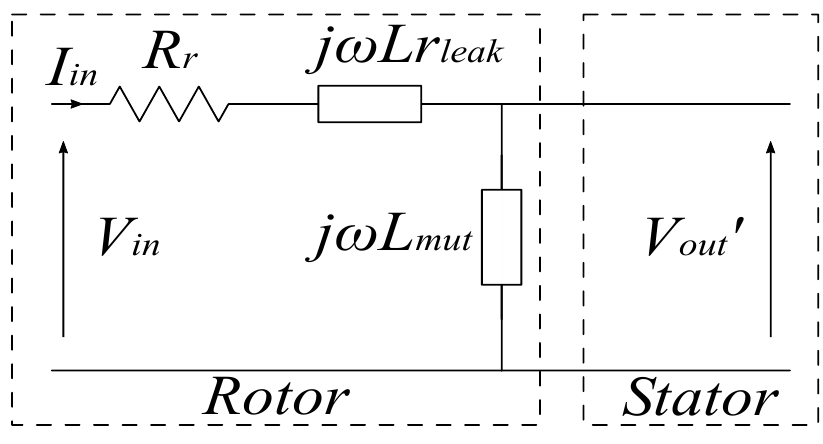
Figure 3. Equivalent circuit referring to the